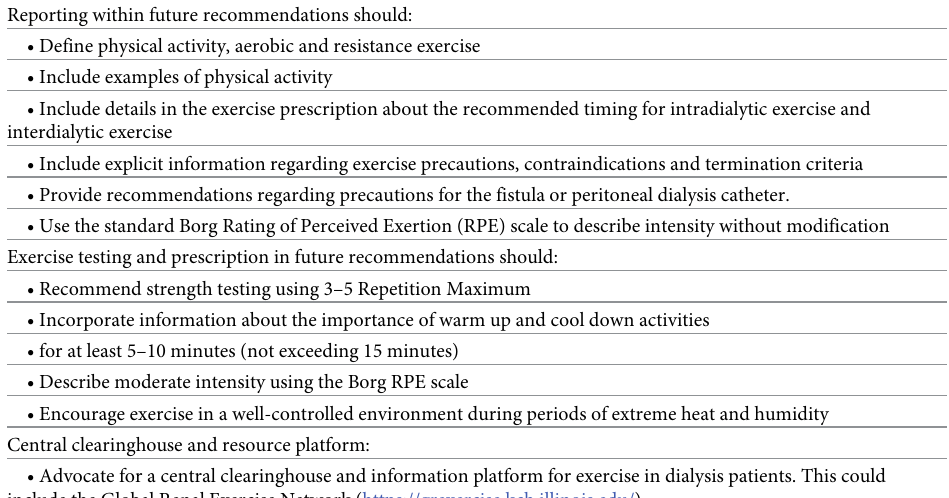
Table 4. Summary of recommendations from scoping review